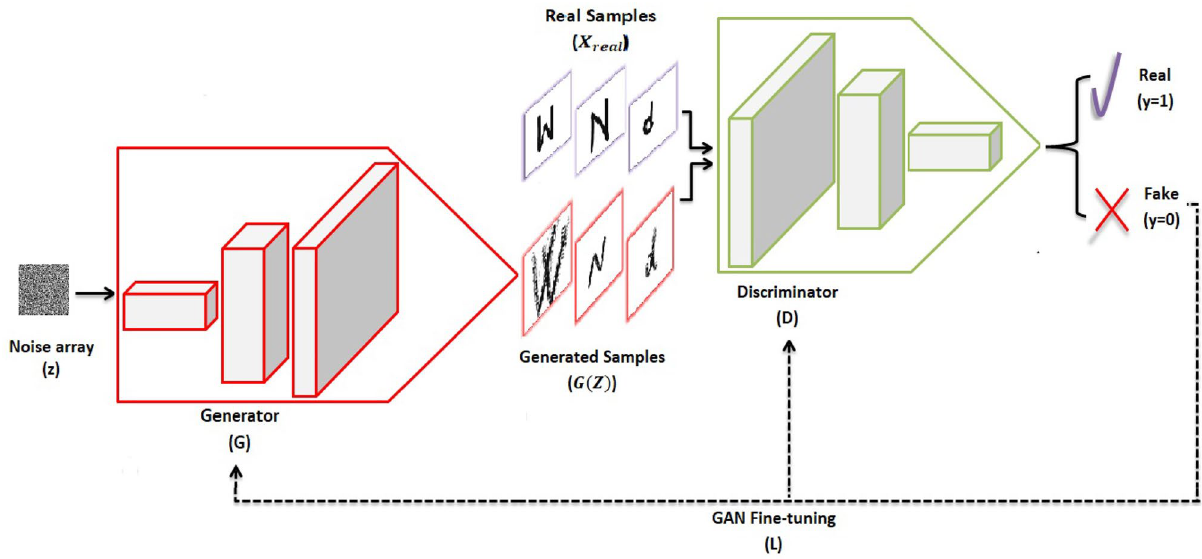
Figure 3. GAN architecture consists of two networks trained simultaneously, G and D . G generates synthetic samples that D tries to make